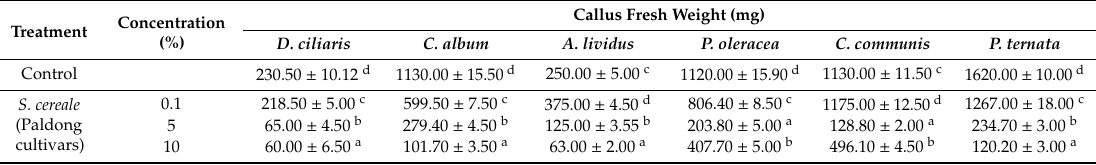
Table 1. E ff ect of S. cereale (Paldong cultivars) extracts on the fresh weight of callus. Treatment